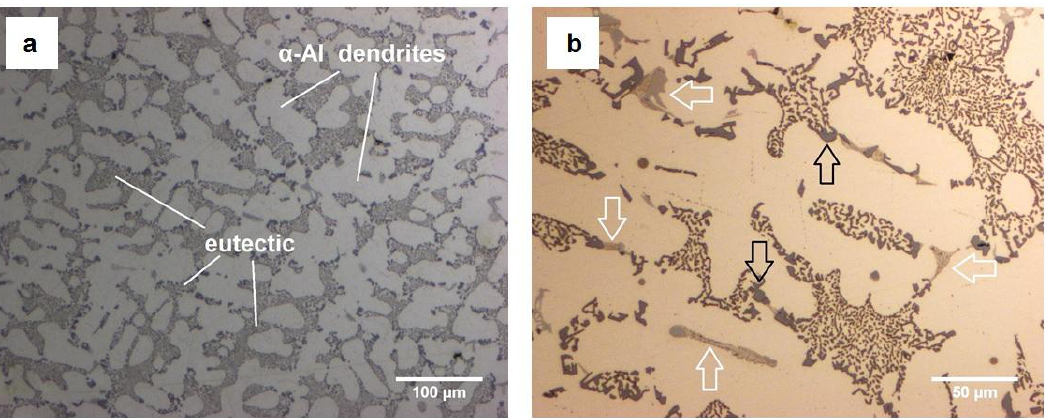
Figure 1. Optical micrographs of the as cast A354 alloy: ( a ) dendritic structure surrounded by eutectic silicon particles and ( b ) higher magnification image showing coarse intermetallics formed during solidification (white arrows) and eutectic Si particles, partially unmodified (black arrows).